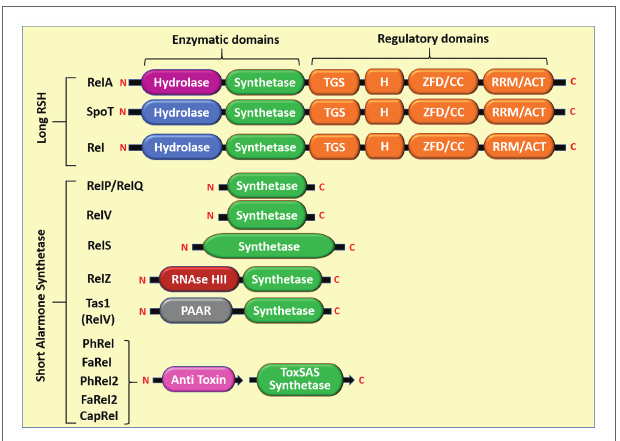
FIGURE 1 | Domain structure of long RelA/SpoT homolog (RSH) and short alarmone synthetase (SAS). SAS proteins have only (p)ppGpp synthetic domain (~25–29 kDa), the hydrolysis and regulatory domains are absent. RelS is a 39.8-kDa protein with extended synthetase domain than other SAS. RelZ is a 64.5-kDa protein with RNase HII domain. The hydrolysis and regulatory domains are TGS, ThrRs, GTPase, and SpoT; H, helical domain; ZFD, zinc finger domain; CC, conserved cysteine; RRM, ribosome recognition motif; ACT, aspartokinase, chorismate mutase, and TyrA. Tas1 synthetase is a toxin effector domain, and proline-alanine-alanine-arginine (PAAR) is a toxin delivery domain; PhRel, FaRel, PhRel2, FaRel2, and CapRel are known as ToxSAS because of their presence in toxin–antitoxin (TA) module.